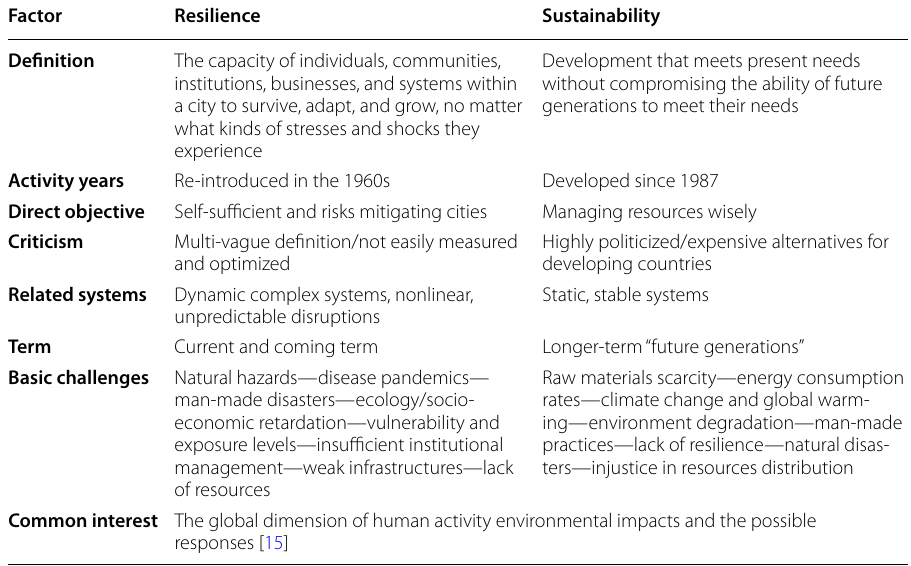
Table 3 Resilience and sustainability features